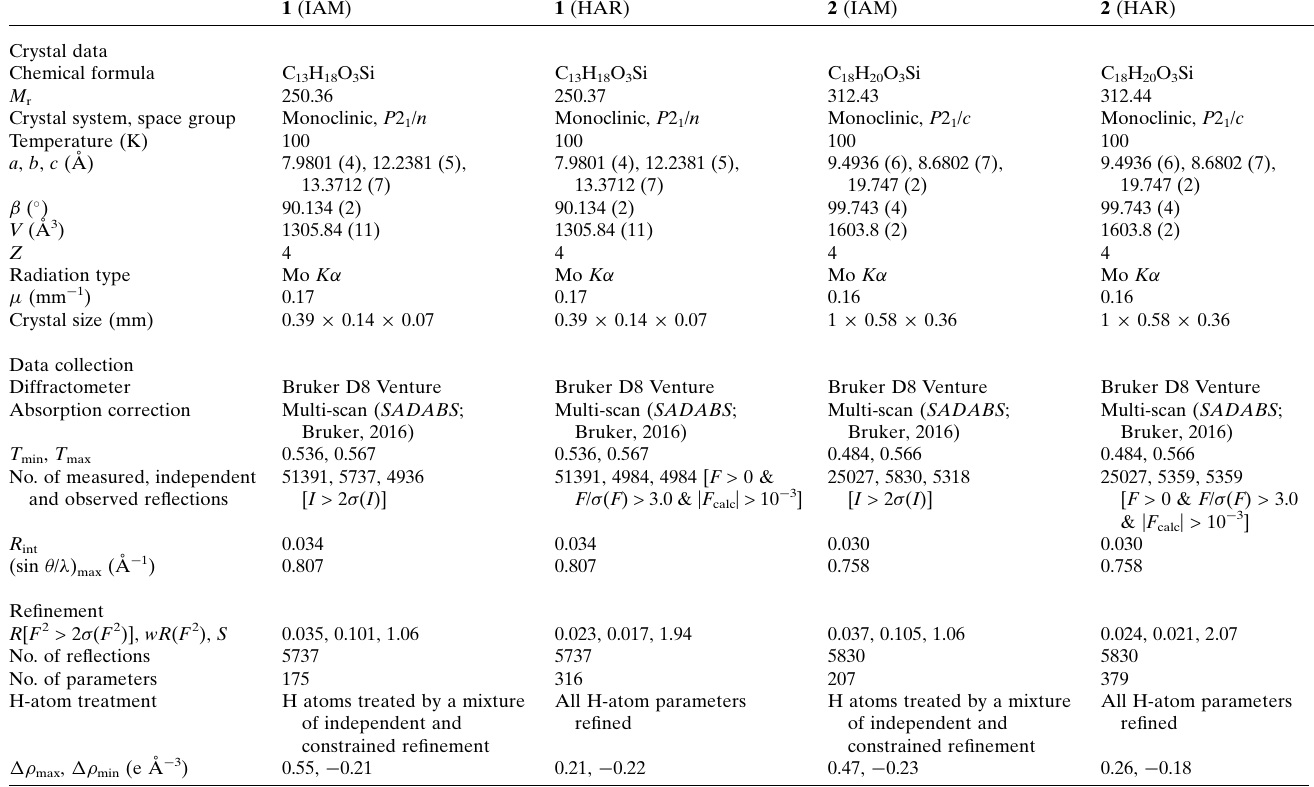
Table 6 Experimental details.